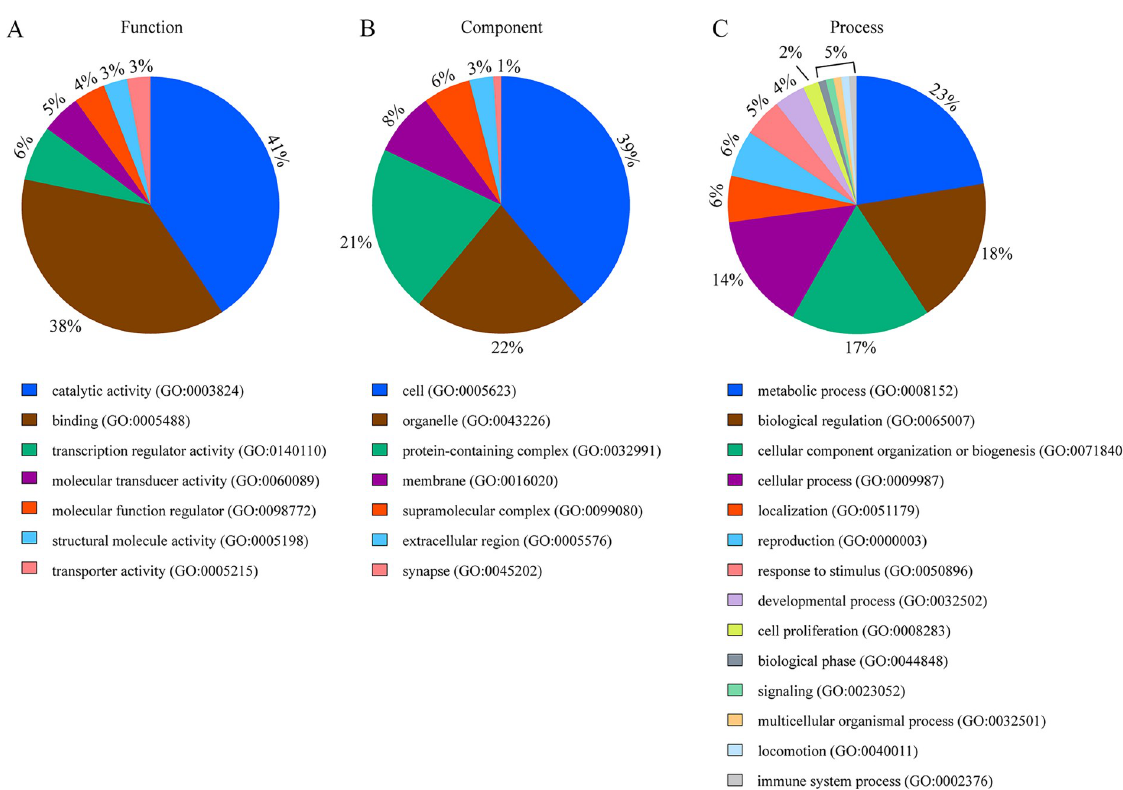
Fig 2. Gene Ontology enrichment analysis of differentially expressed LVSI in endometrial cancer. (A) Molecular function; (B) Cellular component; (C) Biological process.